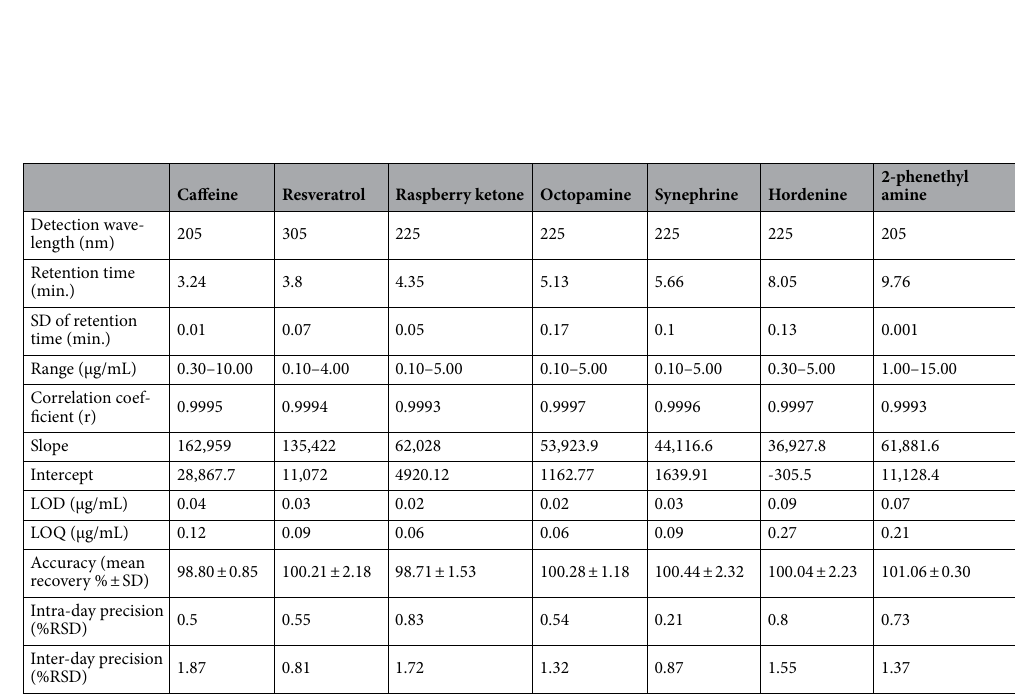
Table 1. Regression parameters and assay validation results of the proposed HPLC